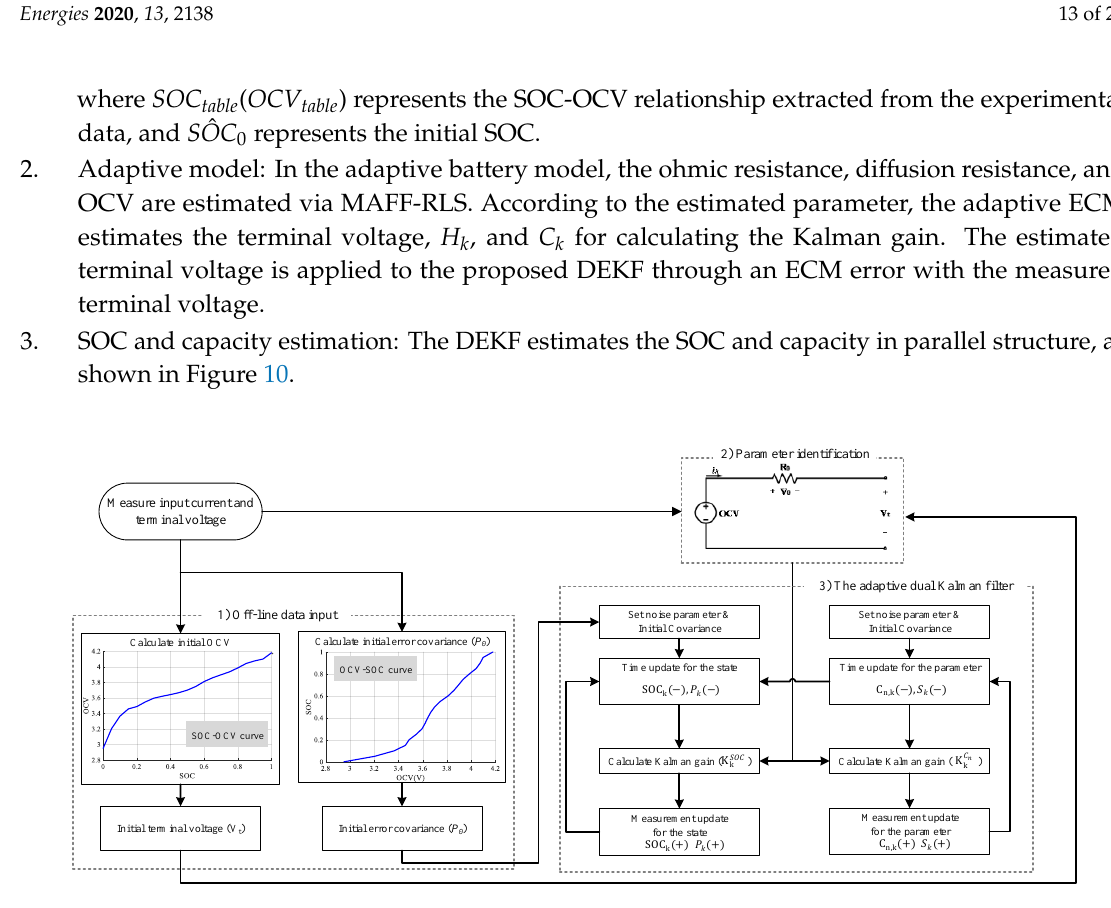
Figure 10. Flowchart of the dual extended Kalman filter